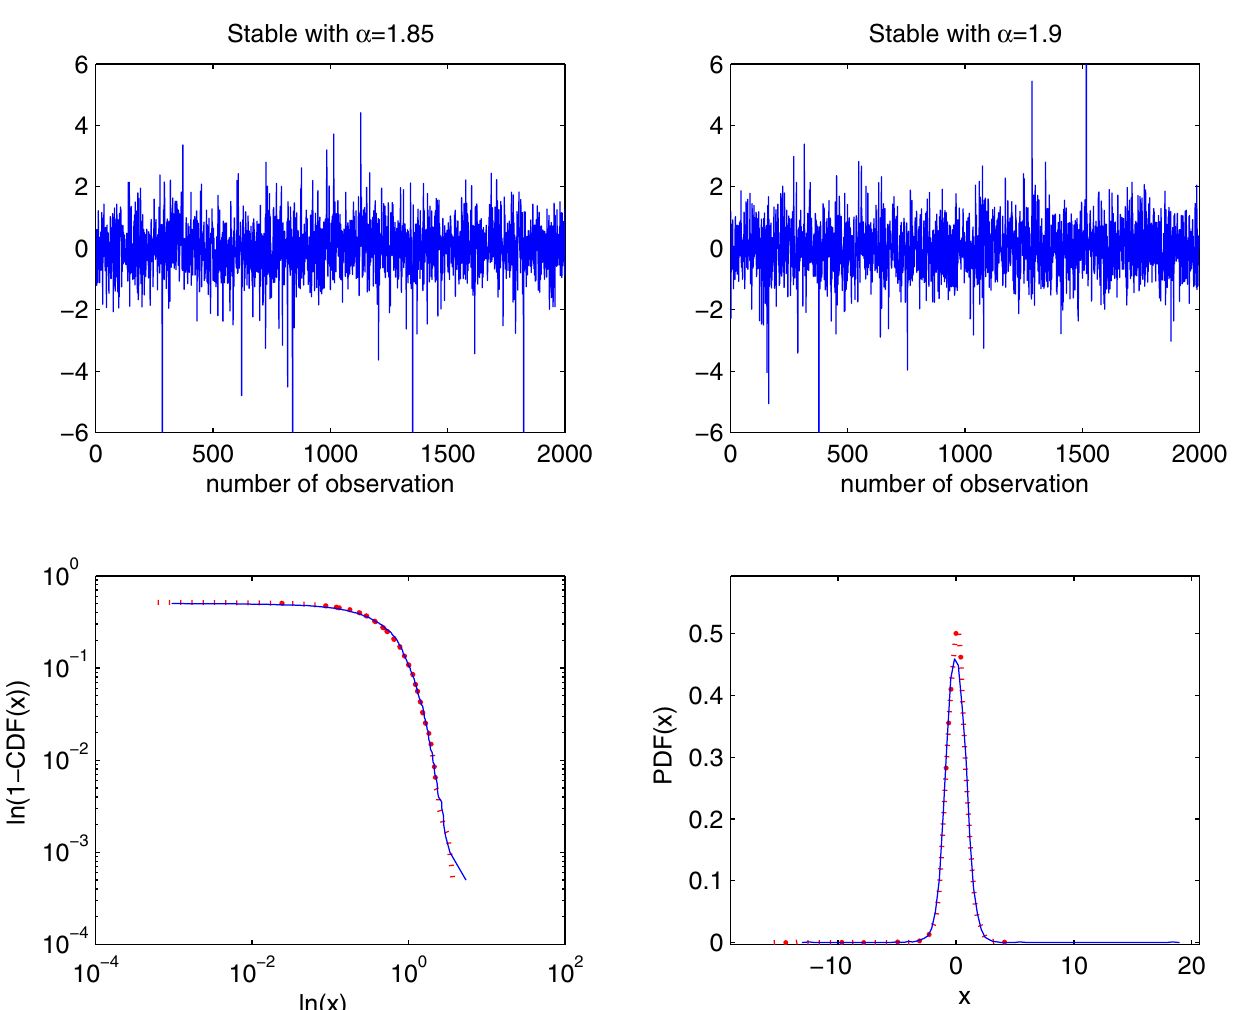
Fig 9. Simulated samples from the symmetric stable distribution with α = 1.85 and σ = 1 (top left panel) and symmetric stable distribution with α = 1.9 and σ = 1 (top right panel), and their empirical tails in log-log scale (bottom left panel) and PDFs (bottom right